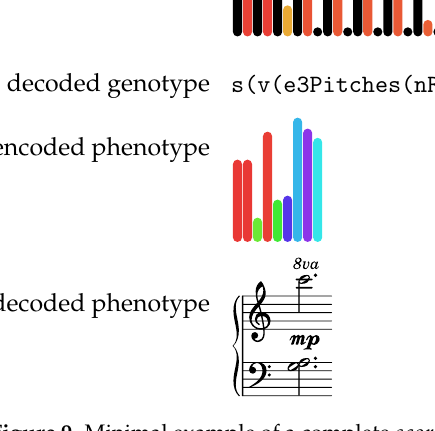
Figure 9. Minimal example of a complete score specimen. This score has only one voice, and the voice includes only one event. However, the event type function e3Pitches generates a chord with three pitches (randomly produced with the function mRnd ). Note that red-orange bars represent golden encoded values: in the genotype referring to function indices; in the phenotype indicating one voice in the score, one event in the voice, and three pitches in the